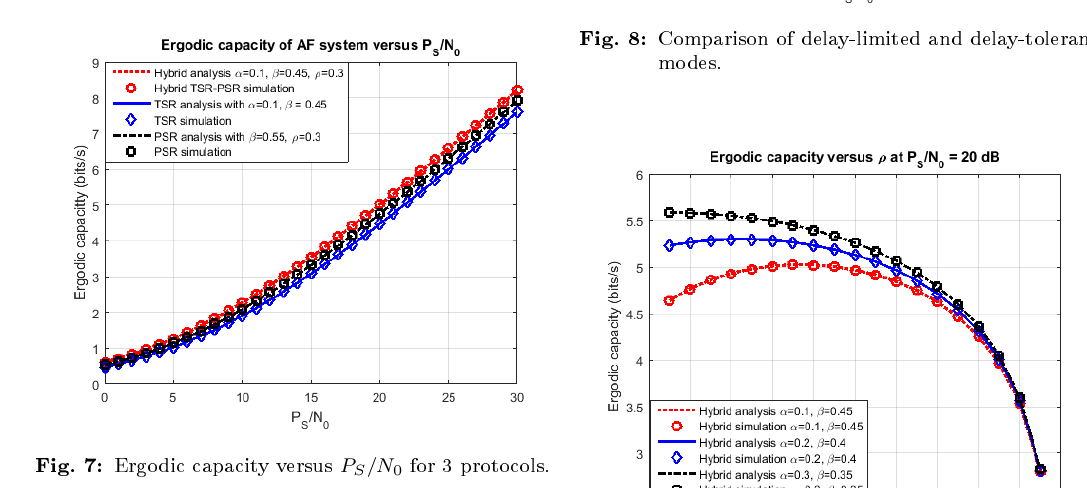
Fig. 6: Throughput versus α for hybrid and TSR pro- tocols.